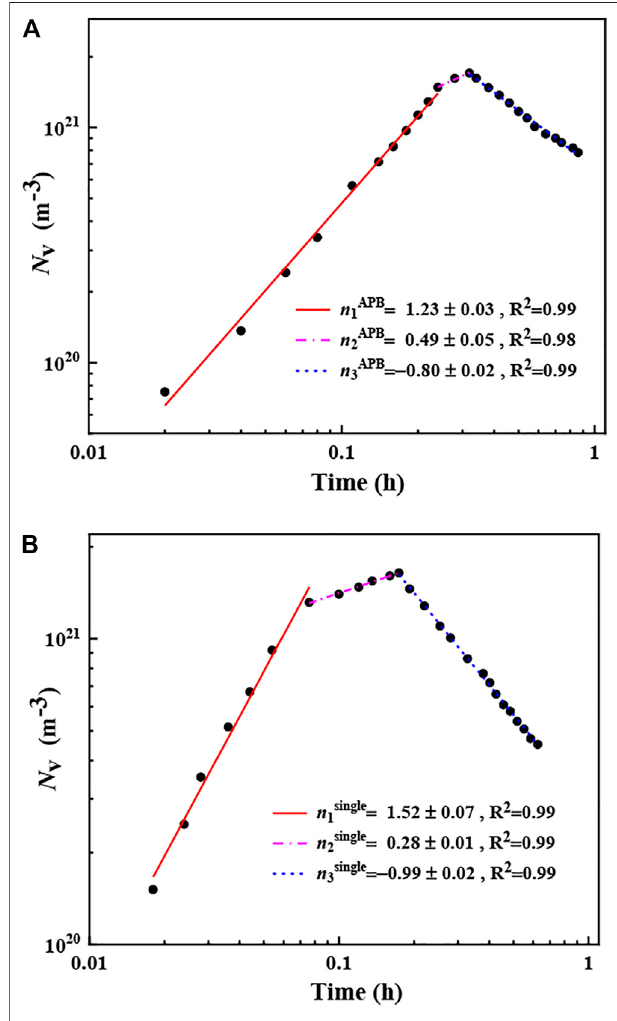
FIGURE4| Evolutionoftheparticlesnumberdensityofthe γ ′ phasewith time in Co – 10Al – 10W at% alloy aged at 1173 K: (A) four APDs and (B) single